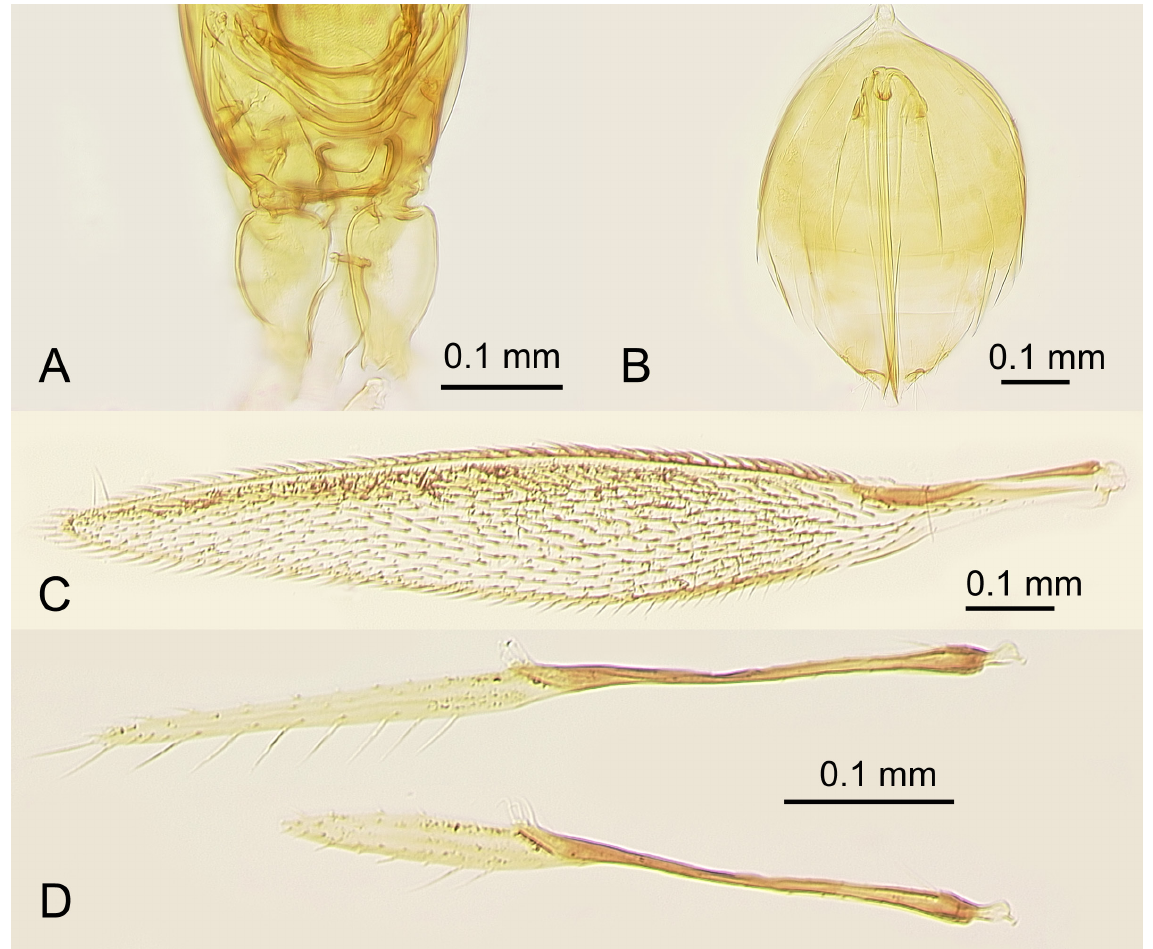
Fig. 7. Ganomymar dessarti De Santis, 1972, non-type, ♀, (CASENT 2079165), Andasibe-Mantadia National Park, Alaotra-Mangoro Region, Madagascar. A . Propodeum and petiole. B . Gaster. C . Fore wing. D . Hind